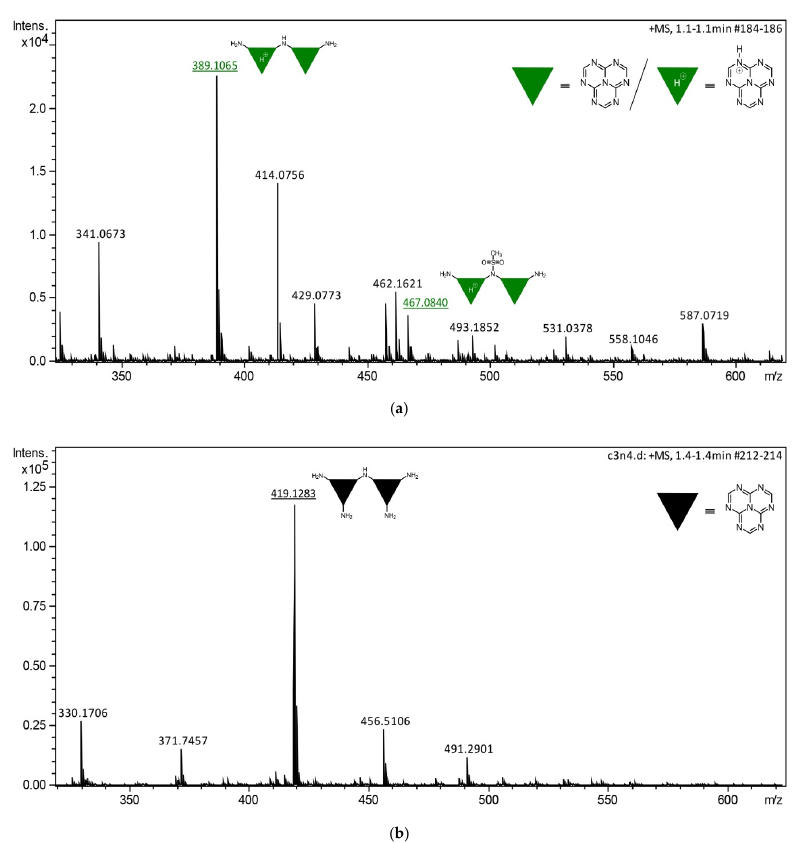
Figure 6. ( a ) Mass spectrometry (MS) analysis of Mes-ExCN. ( b ) MS analysis of ExCN.